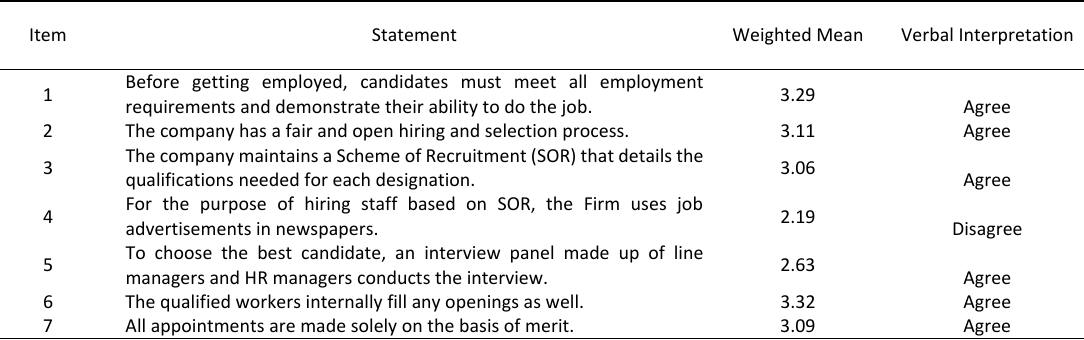
Table 8: Attitude of the respondents towards Recruitment and Selection